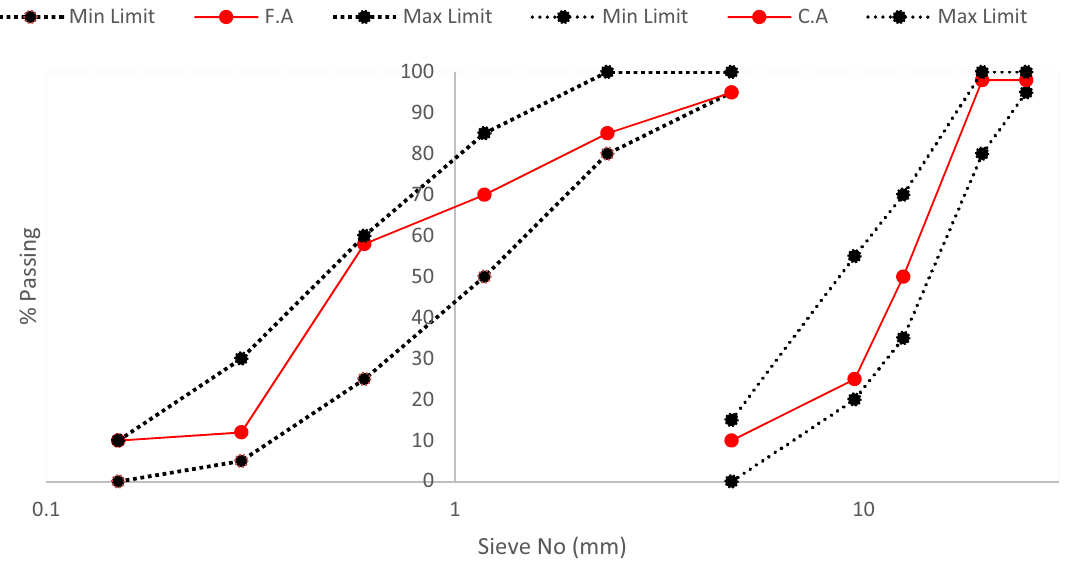
Figure 2. Gradation curve of fine and coarse aggregate.